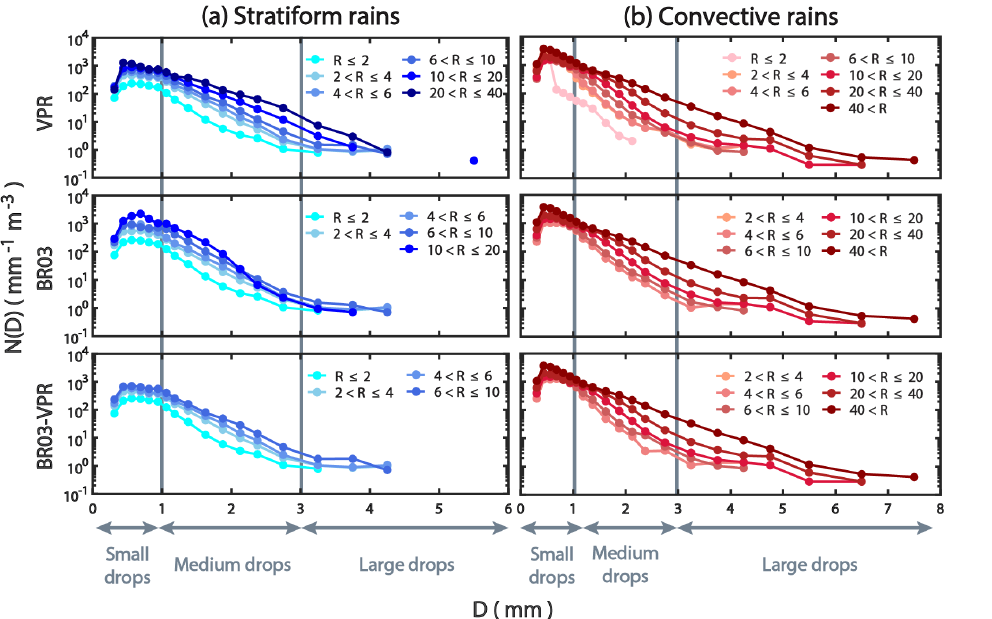
Figure 7. Same as Figure 6, but for ( a ) stratiform rains and ( b ) convective rains with three different separation methods: VPR (top panel), BR03 (middle panel), and BR03-VPR (bottom panel), respectively, in three different diameter ranges: small, medium, and large drops.